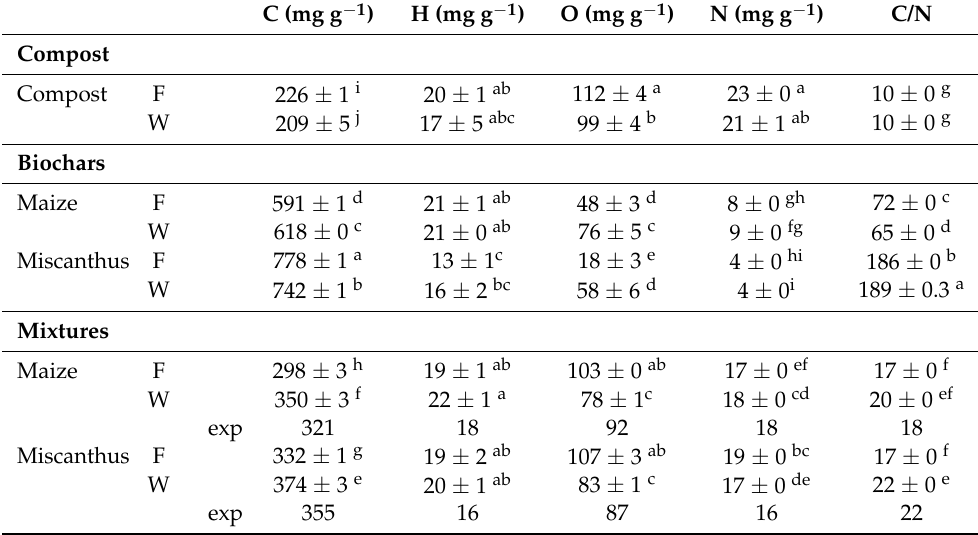
Table 2. Elemental composition of fresh (F) and weathered (W) compost, biochars and biochar- compost mixtures. Expected (exp) values were calculated for the weathered mixtures. Data are presented as means ± sd ( n = 3). The letters represent differences among